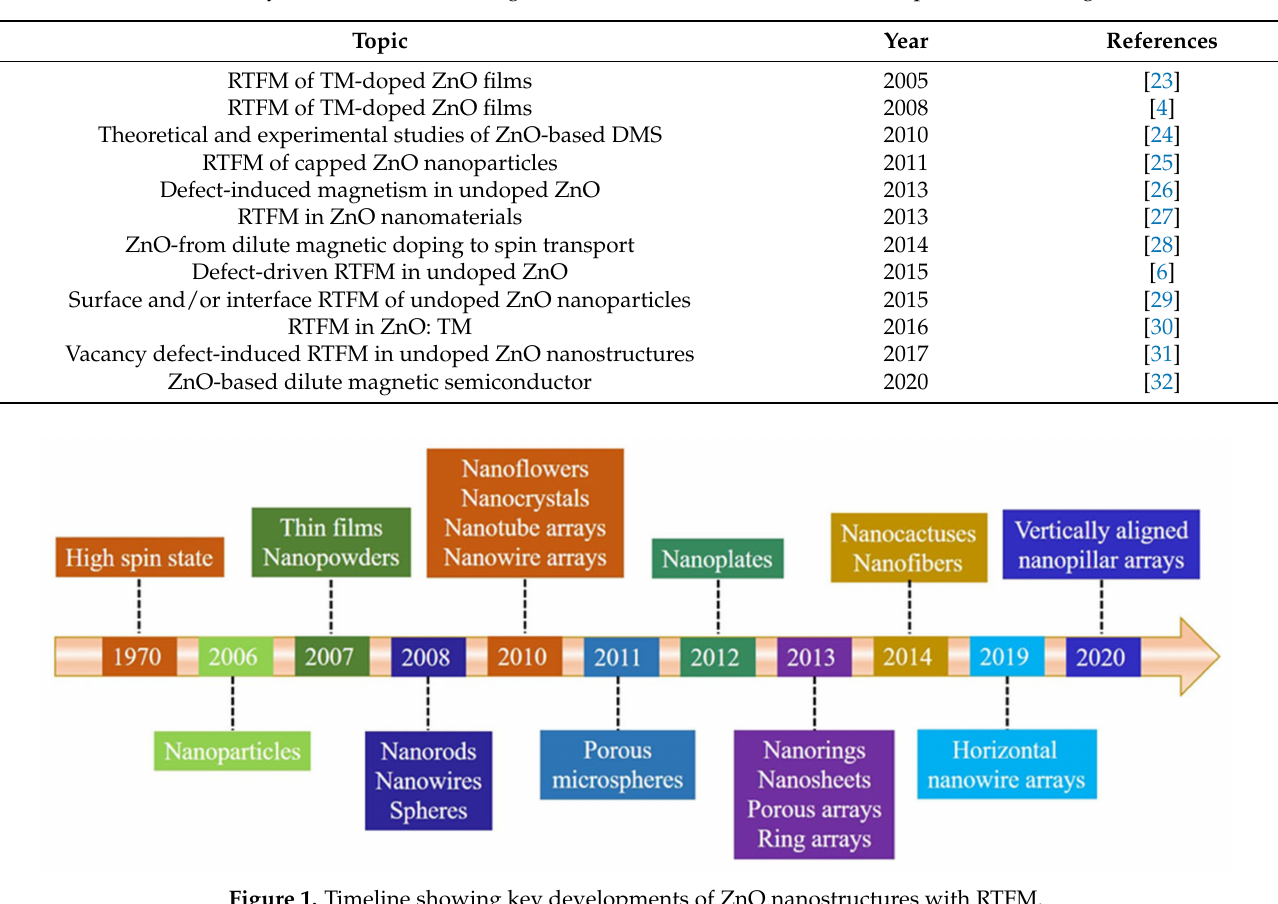
Figure 1. Timeline showing key developments of ZnO nanostructures with